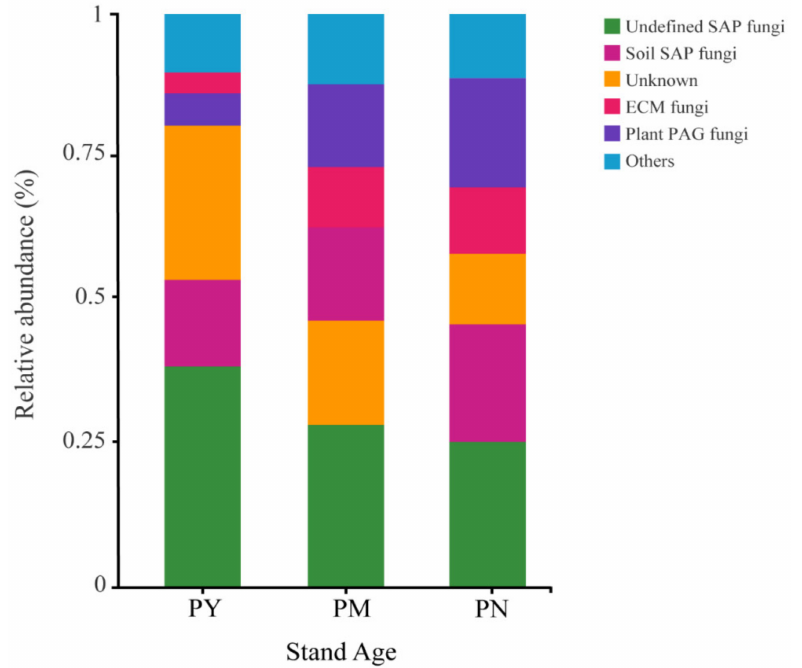
Figure 5. Functional taxonomic composition of rhizosphere soil fungal communities of P. tabuliformis at different stand ages. SAP: saprotrophic, ECM: ectomycorrhizal, PAG: pathogenic, PY: young forest (10a), PM: middle-aged forest (20a), and PN: near-mature forest (30a).